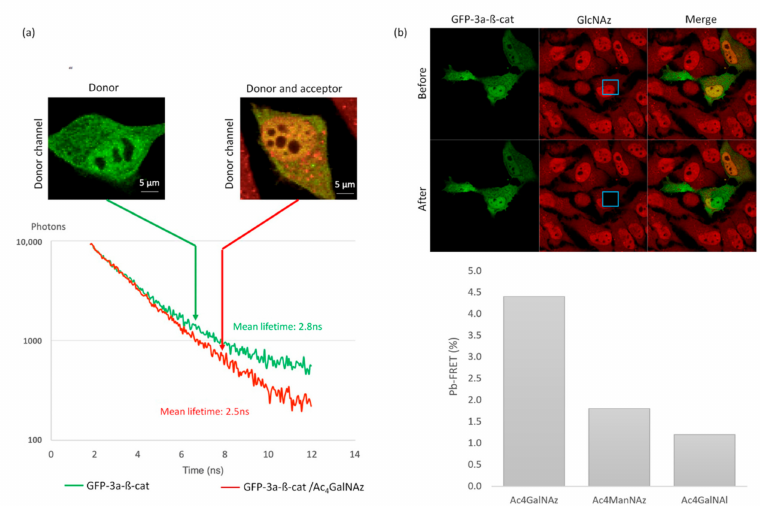
Figure 5. Proof of feasibility: FRET imaging of O -GlcNAcylated GFP-3a- β -catenin. ( a ) SLiM-FRET experiment using two-photon excitation: representative photon decay curves and associated fluorescence mean lifetime extracted from only the GFP emission channel. ( b ) Donor dequenching after acceptor photobleaching. The inserted blue box indicates the photobleached area. Histograms correspond to calculated pb-FRET inside the cells after photobleaching in comparison to Ac 4 GalNAl and Ac 4 ManNAz, which serve as a negative